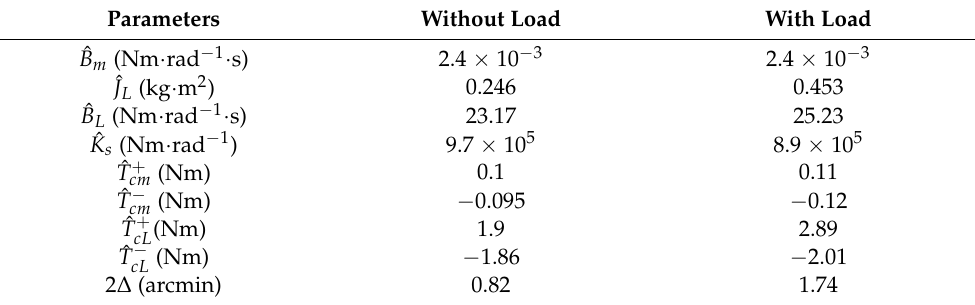
11 of 14 Figure 6. Convergence process of multi-parameter online identification in the experiment. ( a ) Without load; ( b ) With load. The identification results show that the multi-parameter online identification method can not only recognize the adjustment of load but also detect the change of backlash and friction when the load varies. The backlash and friction torque increase with the increase of the mass blocks. The reason is that with the mass blocks added, the pressure on the bearing increased, and the Coulomb friction torque is proportional to the pressure, so the friction torque increased. When the increment of friction torque is greater than the inertia torque, the angular forward movement of the load due to the inertia would reduce, so the measured backlash would enlarge. Table 2. The converged values of the identification results in the experiment.